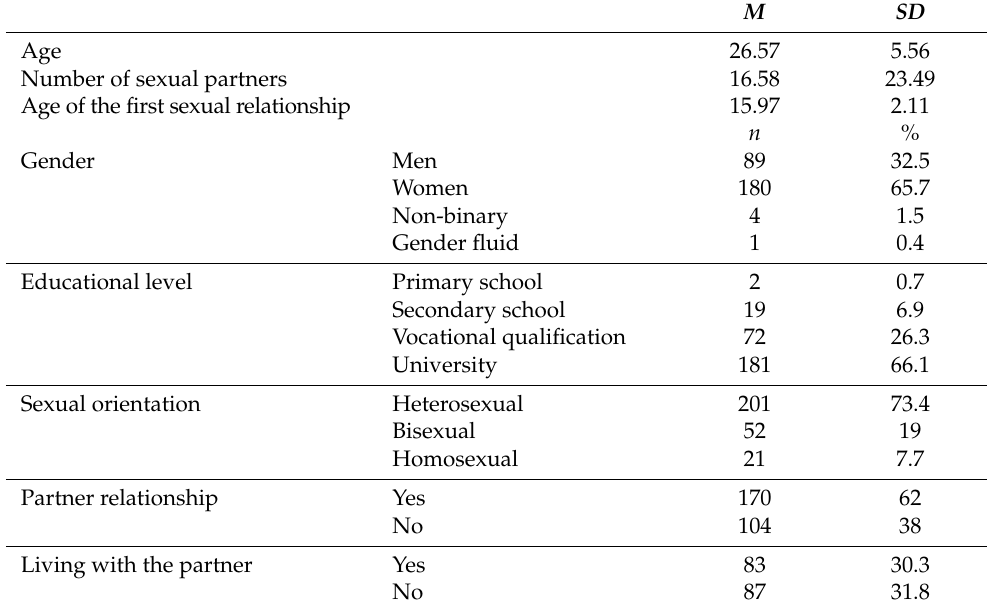
Table 1. Descriptive statistics of the